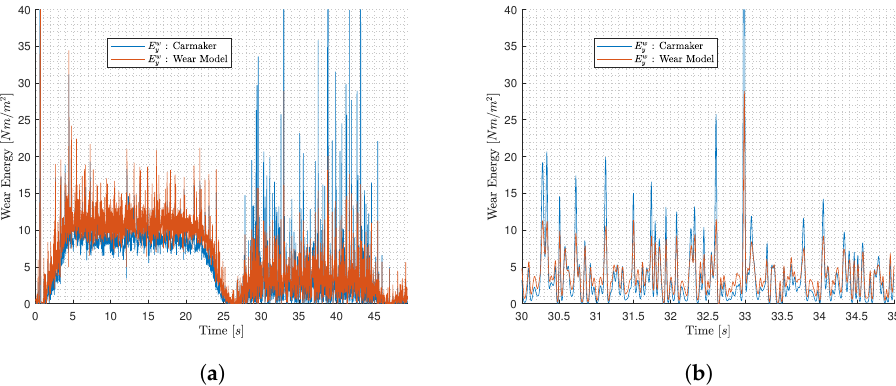
Figure 7. The comparison of E w y interval 30–35